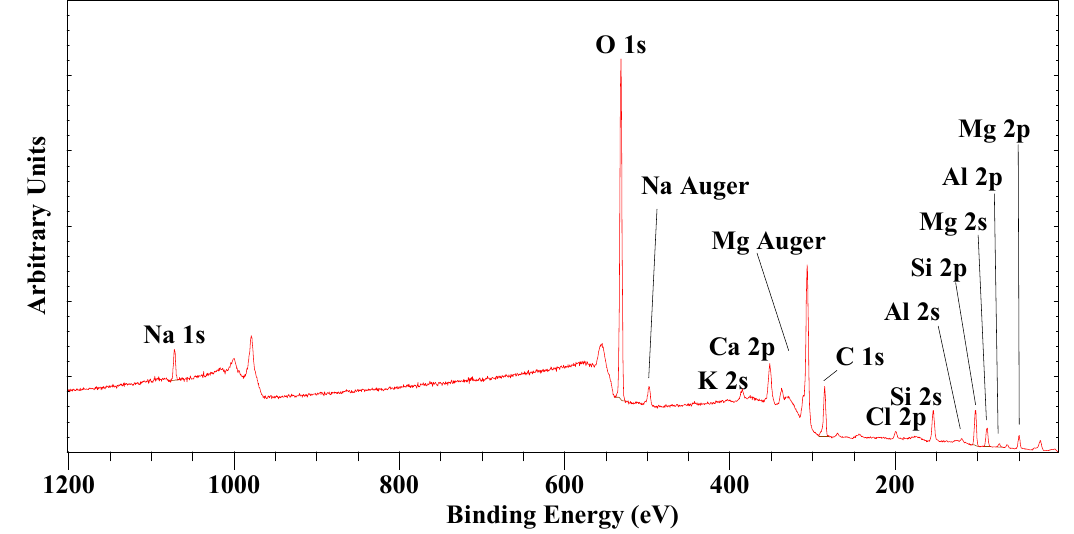
Figure 11. X-ray photoelectron spectroscopy (XPS) survey scan from 1200 to 0 eV of natural saponite SapCa1. Table 5. Chemical composition of saponite SapCa-2 (in atom %) based on survey XPS analyses with Si as reference in comparison to data (in atom %) from Data handbook for Clay Minerals and Other Non-metallic Minerals [88] and Clays and Clay Minerals Special Issue 49 (5) Source Clays (2001) [89]. Oxygen is not included.